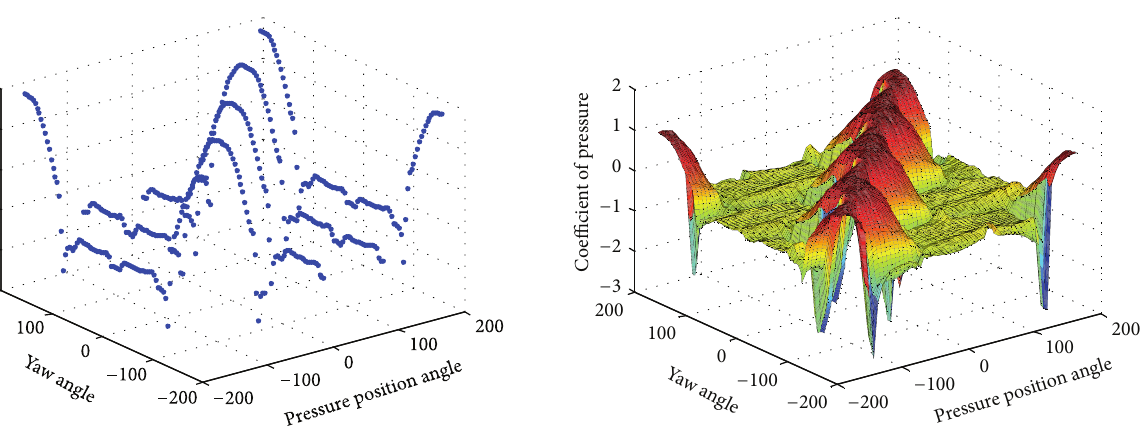
Figure 12: Wind tunnel coefficient of pressure as a function of yaw angle and pressure sensor position.